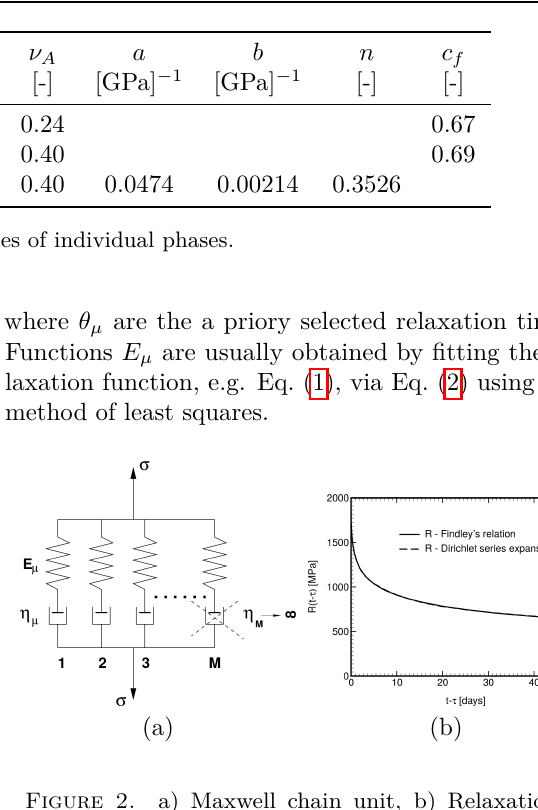
Figure 1. Example images of local microstructure: a) carbon fibers, b) basalt fibers. Reprinted from [9] with permission from Begell House Publishers.